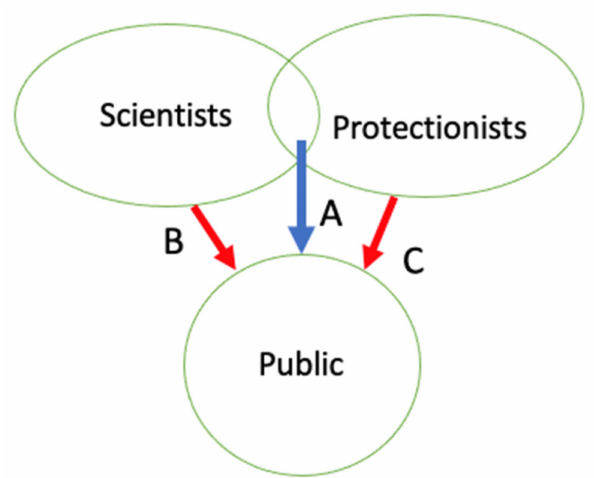
Figure 3. Animal-use information flow when scientists and animal protectionists work together to develop practices and knowledge—together sharing information with the public. ( A ) Protectionists and scientists co-produce knowledge and share it with the public with maximum opportunity for public input on what they want to know. ( B , C ) Scientists and protectionists maintain their right to honestly communicate their “side” where they do not reach a common